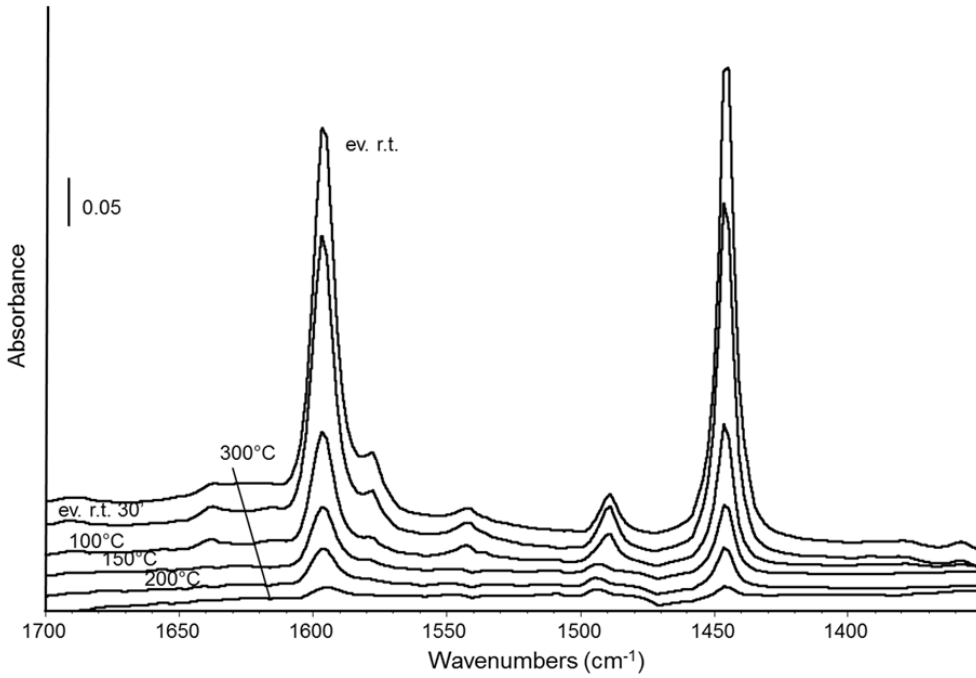
Figure 8. FT-IR subtraction spectra of surface species arising from pyridine adsorption over SBA-15 support after pre treatment in 1,2DCP in the range 50–500° C.